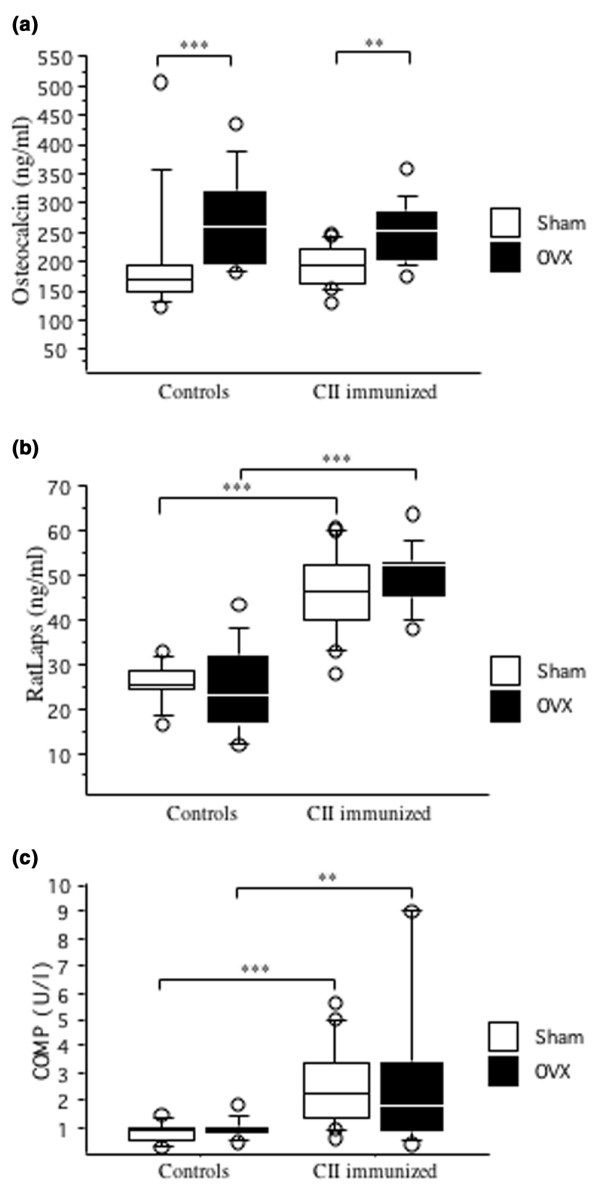
Ovariectomy increased bone formation and arthritis increased bone resorption and cartilage destruction. (a) Ovariectomy (OVX) increased bone formation. Serum levels of osteocalcin were analyzed by immunoradiometric assay. (b) Arthritis increased bone resorption. Serum levels of RatLaps were analyzed by ELISA. For controls, n = 10 for sham (open boxes) and ovariectomy (filled boxes); for immunized mice, n = 18 for sham and n = 15 for ovariectomy. (c) Arthritis increased cartilage destruction. Serum levels of cartilage oligomeric matrix protein (COMP) were analyzed by ELISA. For controls, n = 9 for sham (open boxes) and n = 10 for ovariectomy (filled boxes); for immunized mice, n = 17 for sham and n = 14 for ovariectomy. **P < 0.01, ***P < 0.001. Results are shown as box plots (values are given as medians (horizontal lines), interquartile ranges (box) and ranges (whiskers), circles represent outliers).